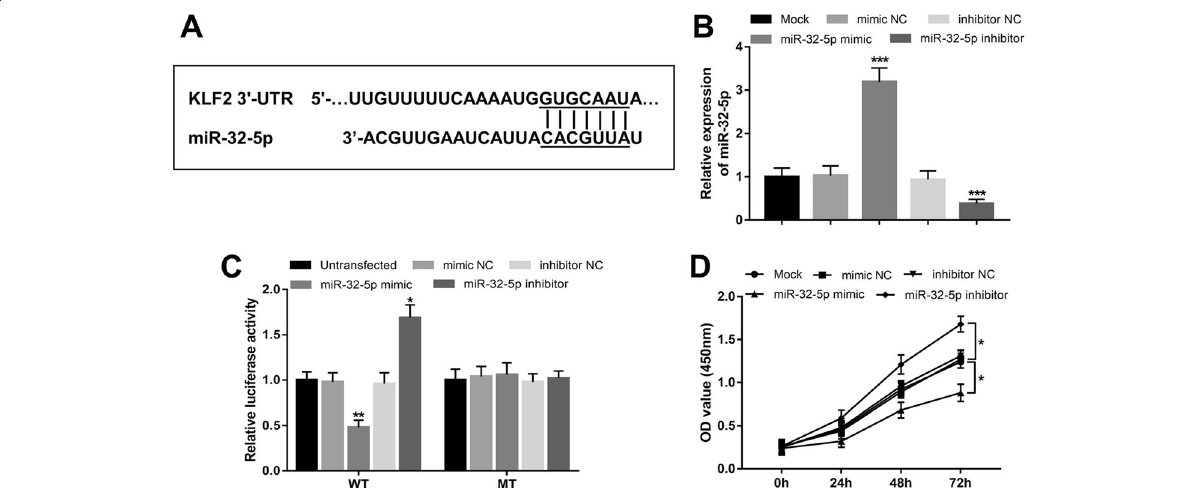
Fig. 1 Interaction of miR-32-5p with KLF2 and its effect on HUVECs proliferation. a . The binding sequence of miR-32-5p in the 3 ′ -UTR of KLF2. b . Expression of miR-32-5p was successfully upregulated by the miR-32-5p mimic, and was downregulated by the miR-32-5p inhibitor. c . The relative luciferase activity in HUVECs with overexpression or knockdown of miR-32-5p. d . HUVECs proliferation was promoted by the downregulation of miR-32-5p, but was inhibited by the overexpression of miR-32-5p. No significant difference was found in miR-32-5p expression, relative luciferase activity and cell proliferation between mock group and mimic NC or inhibitor NC group, which excluded the effect of transfection operations on the detected results. KLF2, Kruppel-like factor 2; 3 ′ -UTR, 3 ′ -untranslated region; NC, negative control; WT, wild type; MT, mutant type; * P < 0.05, ** P < 0.01, *** P <